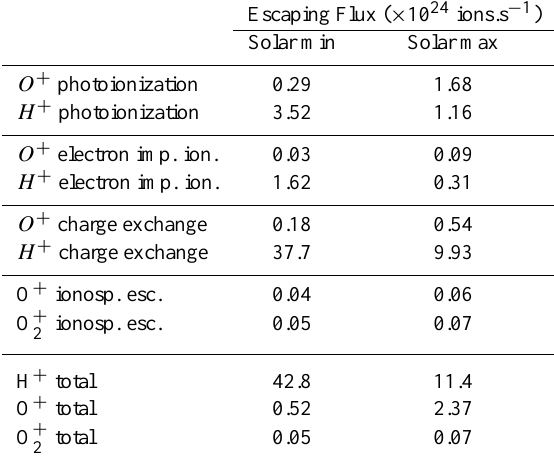
Table 2. Computed fluxes of escaping ions from three-dimensional hybrid simulation for maximum and minimum solar conditions. Contributions of various ionization are detailed following the ion- ization origin of the planetary